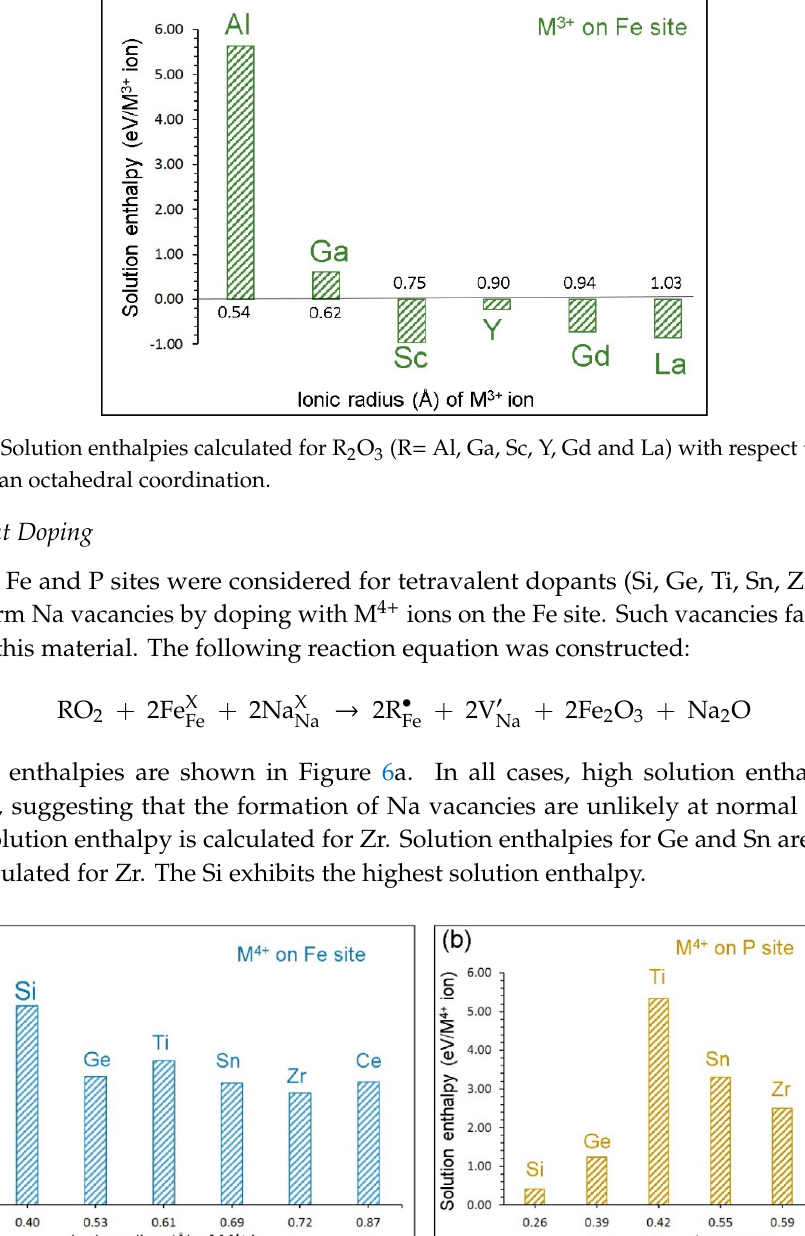
Figure 6. Solution enthalpies calculated for RO 2 (R = Si, Ge, Ti, Sn, Zr and Ce) on ( a ) the Fe site and ( b ) the P site with respect to the M 4+ radius in an octahedral and tetrahedral coordination, respectively.